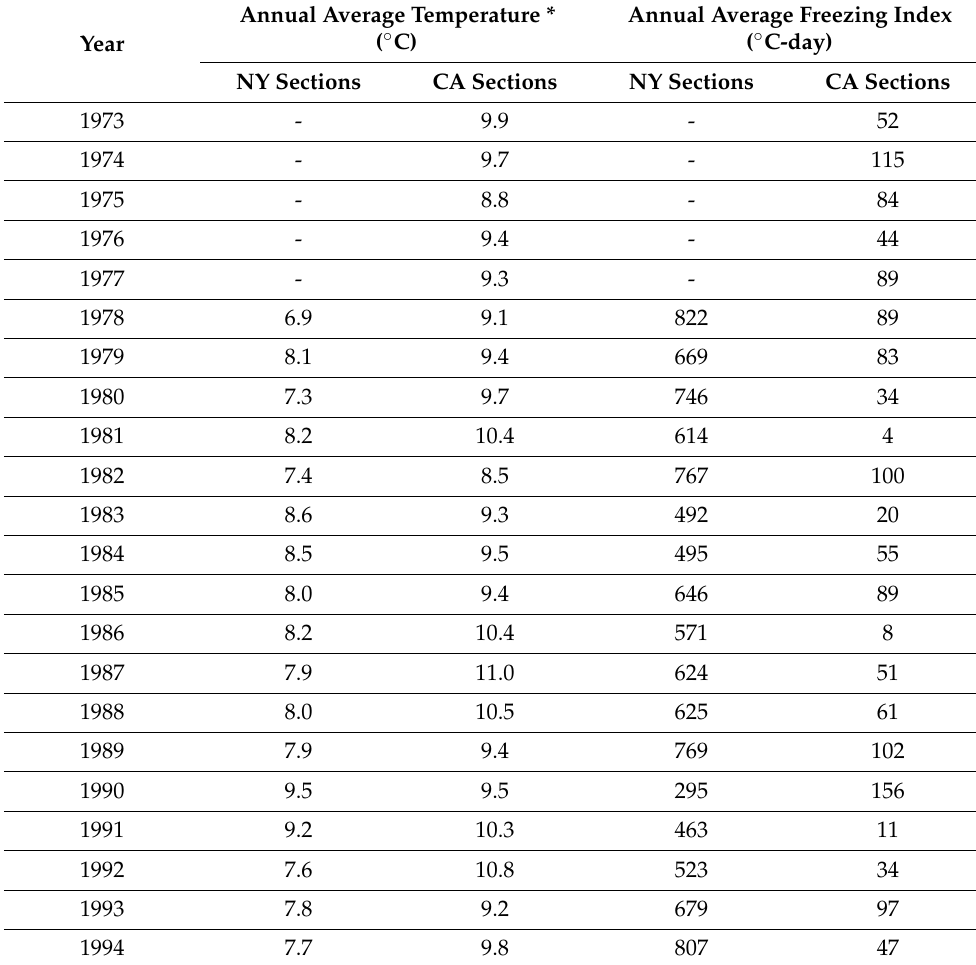
Table 1. Annual average temperature in the locations of the NY and CA pavement test